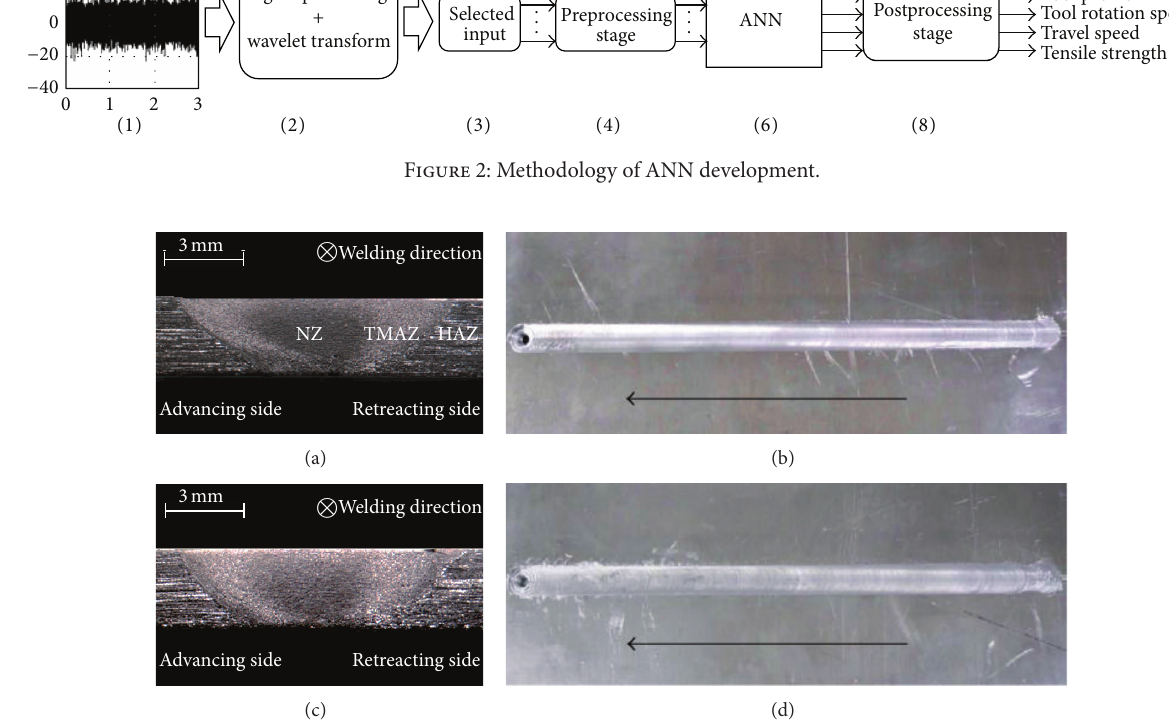
Figure 3: Macrograph of two evaluated conditions. (a-c) Cross-sectional weld zone; (b-d) longitudinal weld zone.